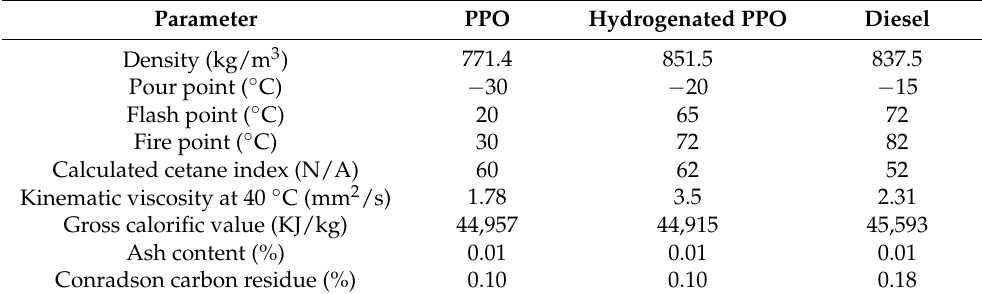
Table 10. Physicochemical properties of PPO, hydrogenated PPO and diesel [119]. Parameter PPO Hydrogenated PPO Diesel Density (kg/m 3